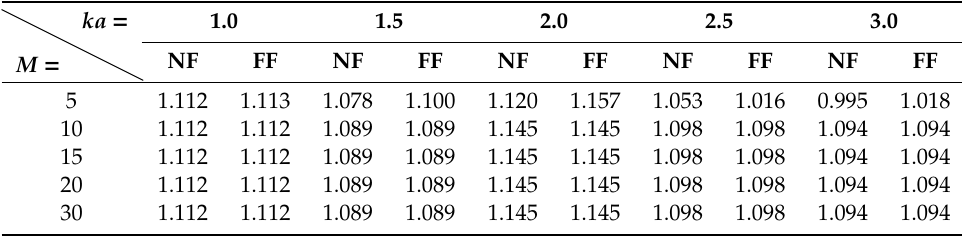
Table 5. Comparison of the normalized mean drift wave force on the concentric porous cylinder system, f − , based on di ff erent formulations ( d = 3 a , b = 2 a , and G 0 =